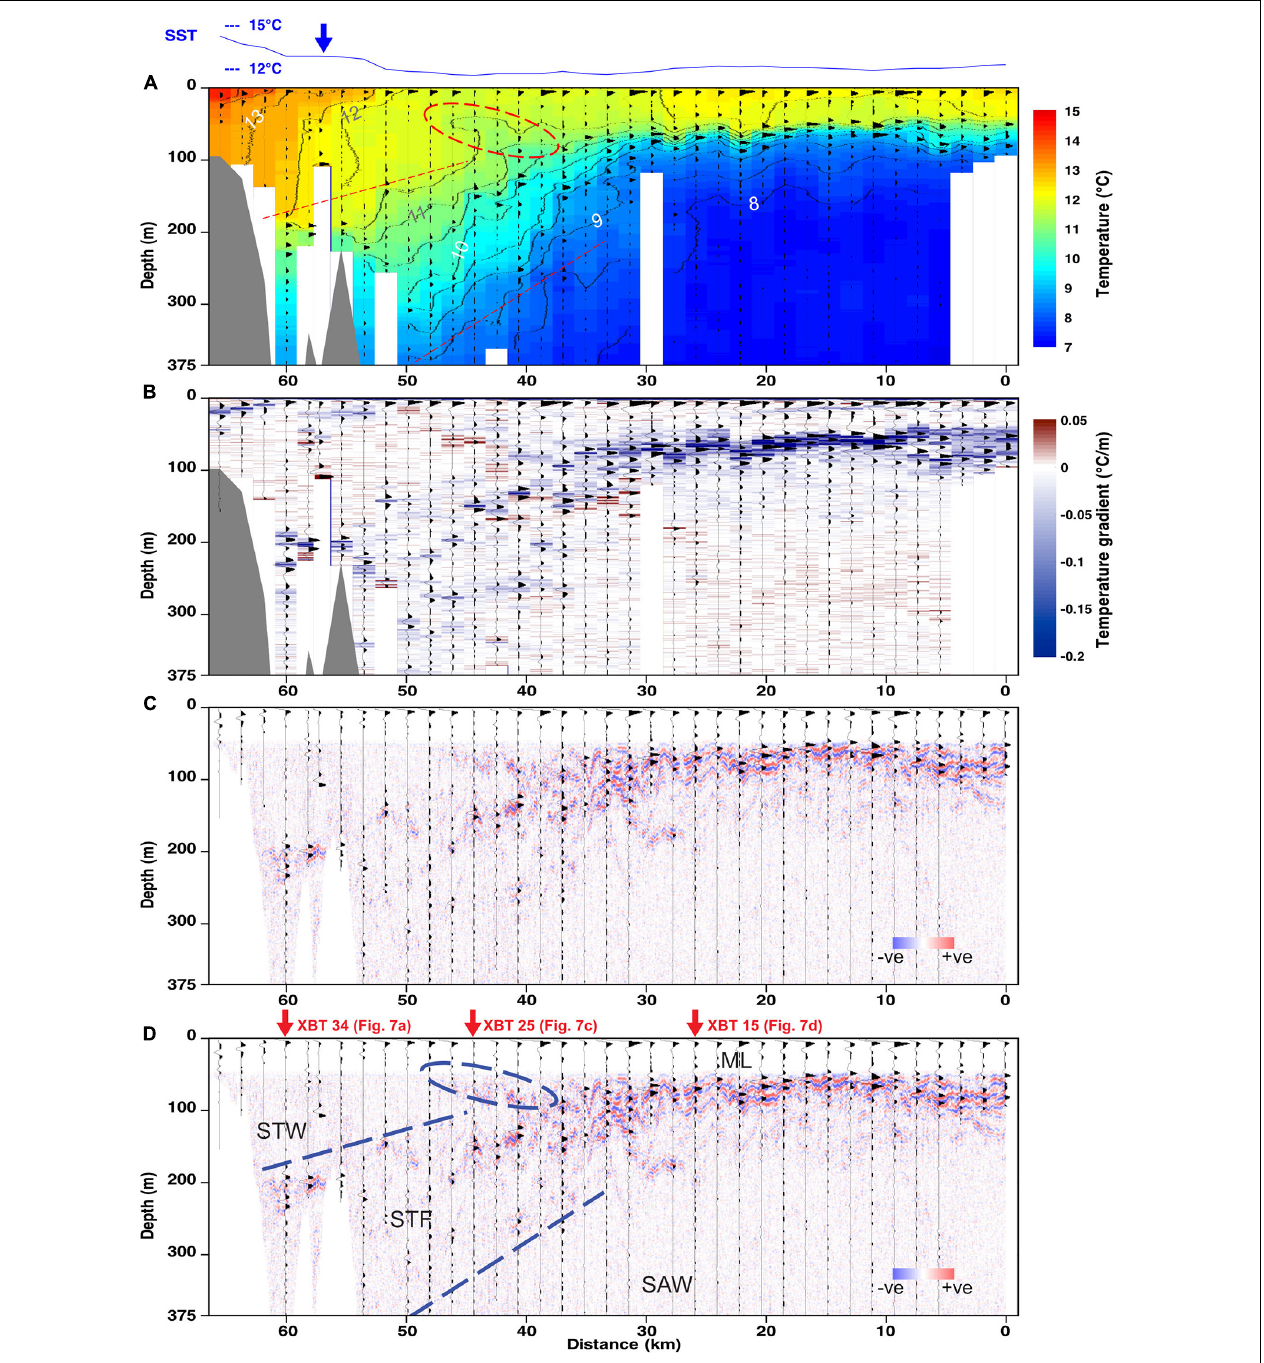
FIGURE 6 | (A) Temperature, (B) vertical temperature gradient, (C) uninterpreted seismic image, and (D) interpreted seismic image for line KAH1201-5, with synthetic seismograms overlain on each image. Shoreward- and seaward-dipping reflective zones separating interpreted water masses are highlighted by dashed lines. STW, Subtropical Water; STF, Subtropical Front; SAW, Subantarctic Water; ML, mixed layer. The surface temperature trace, with approximate surface STF location indicated with an arrow, is shown at the top of (A) . Arrows in (D) indicate the location of XBTs shown in Figure 7 .